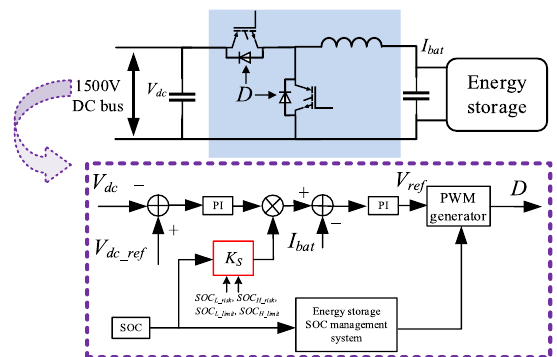
Fig. 5 Energy storage control strategy diagram under K S factor